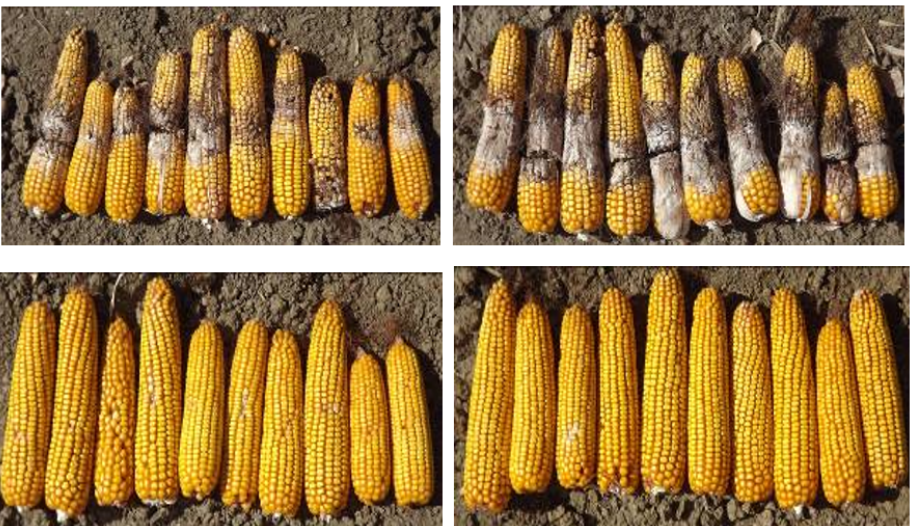
Figure 5. Resistance of hybrid SBL19 against different Fusarium spp. Toothpick method, kernel resistance. ( Left upper ): F. graminearum , a toothpick from inoculation in the 2nd cob from right, ( right upper ): F. culmorum , ( left lower ): F. verticillioides , ( right lower ): naturally infected control.